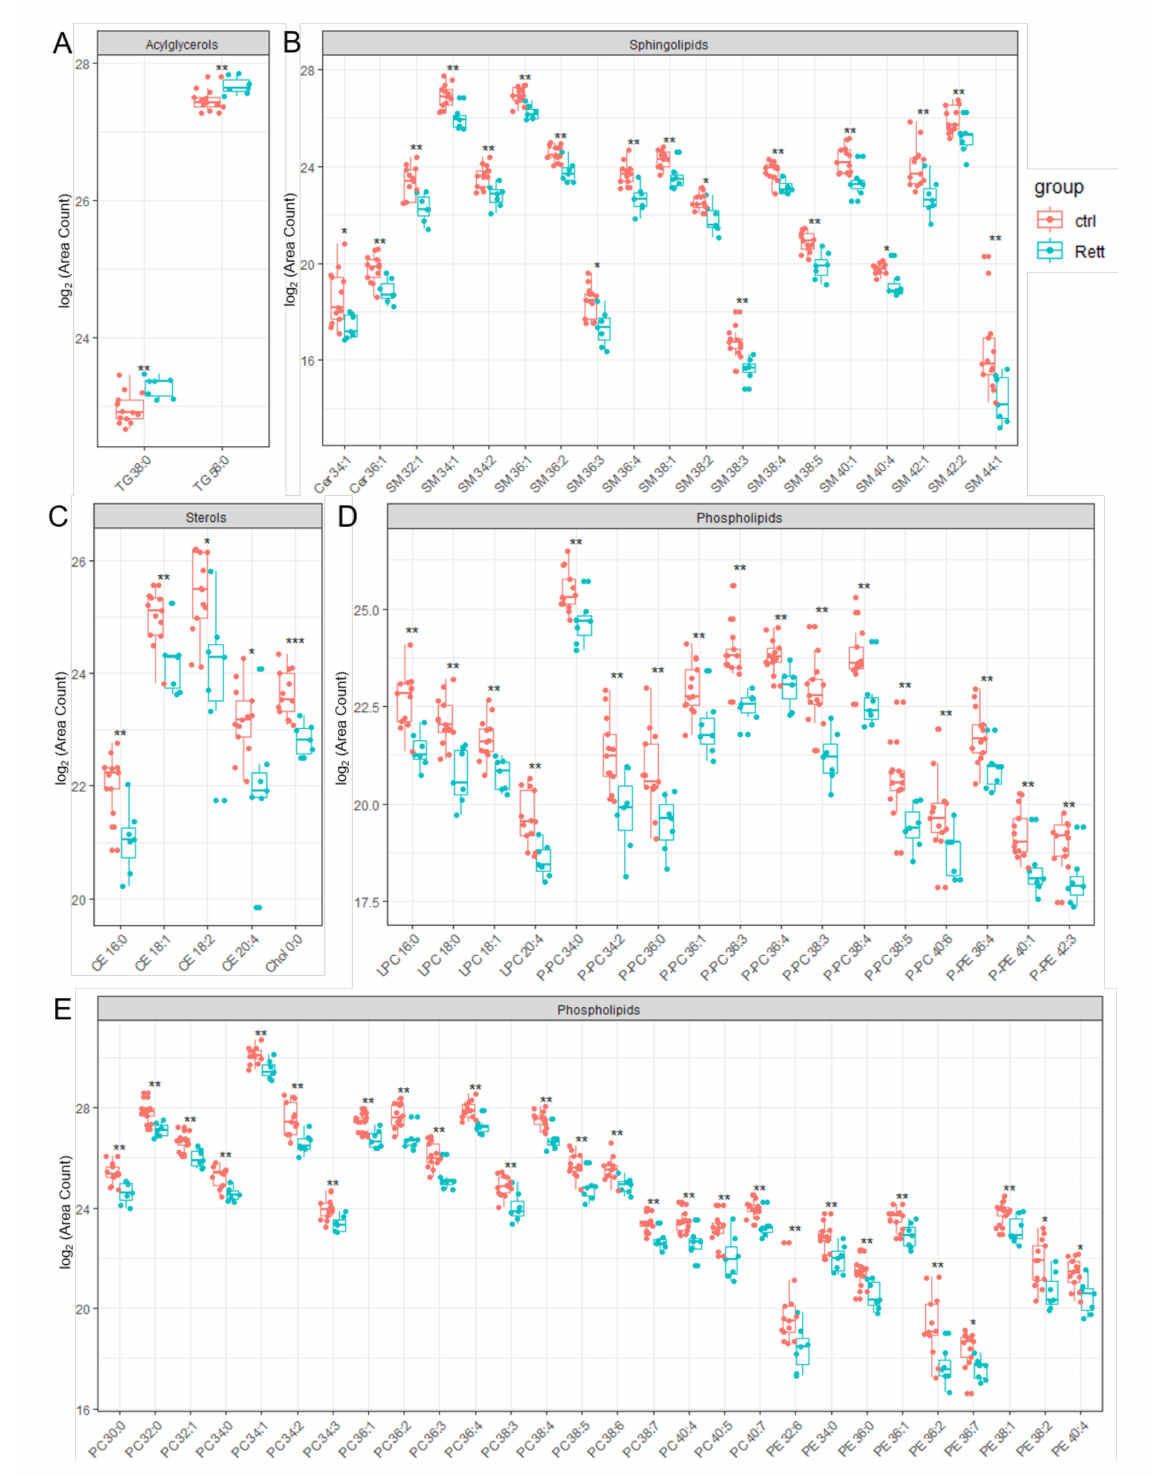
Figure 4. Significant changed lipid species detected in CSF of RTT patients compared to healthy controls. Data is displayed as log 2 of total area count. ( A ) TG (Triacylglycerol), ( B ) Sphingolipids including SM (Sphingomyelin) and Cer (Ceramide), ( C ) Sterols including Chol (Cholesterol) and CE (Cholesterol Ester), ( D , E ) Phospholipids including LPC (Lyso- Phosphatidylcholine), LPE (Lyso- Phosphatidylserine), PC-P (Ether-linked PC), PE-P (Plasmalogens of PE), PC (Phosphatidylcholine) and PE (Phosphatidylethanolamine); *—FDR adjusted p < 0.05 by Wilcoxon rank-sum test , **—FDR adjusted p < 0.01 by Wilcoxon rank-sum test, ns-not